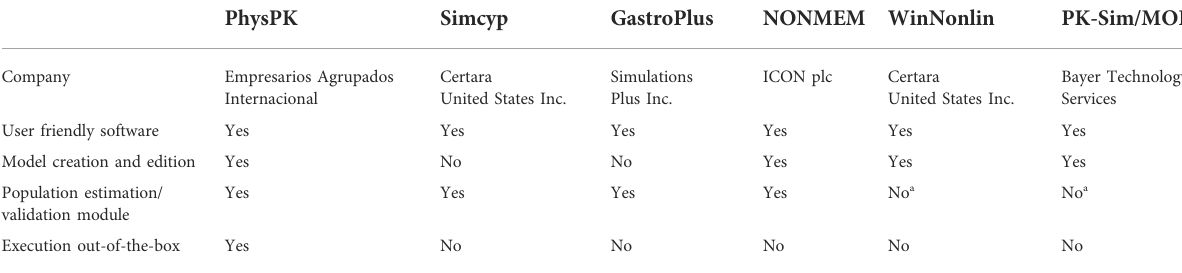
TABLE 6 Comparison of PhysPK and commonly used PBPK software programs.